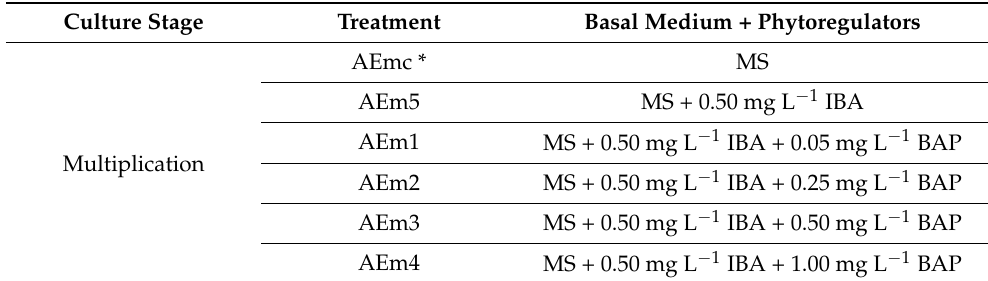
Table 1. Treatments tested for the in vitro multiplication of A. taltalensis during the initial explants culture and shoot subculture.